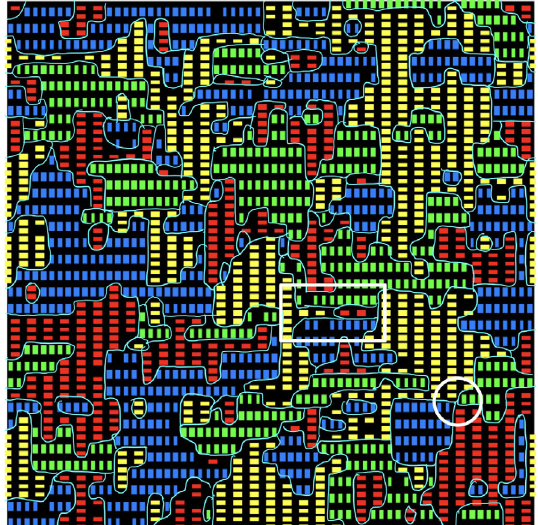
FIG. 8. Visualization of the VBS pattern in the J - Q model generated in simulations with one realization of random bimodal couplings Q ∈ f 0 ; 1 g and J ¼ 0 on a periodic 64 × 64 lattice. The colored links visualize the corresponding correlations h S i · S j i between the spins i and j connected by the link, with the line thickness indicating the magnitude of the correlation. A given link is drawn only if it is the strongest link for both spins i and j , and the color coding corresponds to the convention defined in Fig. 3. The domain boundaries are drawn by hand (turquoise curves). The circle indicates an example of a spinon, at which four domain walls meet (as in Fig. 3 but with a different bond arrangement at the nexus of the domains). The rectangle encloses a segment of a π domain wall in which two spinons are located.